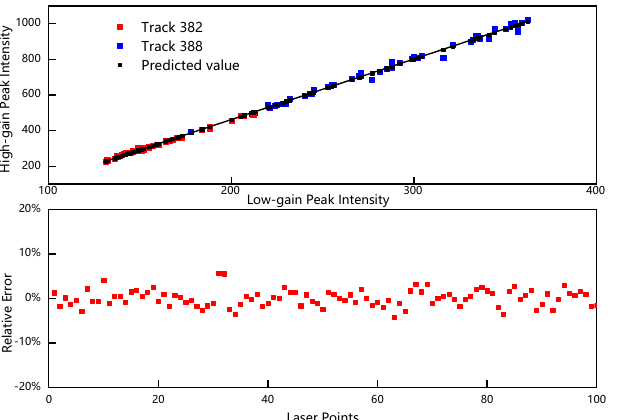
Figure 16. The correlation analysis of the high- and low-gain peak intensity is shown at the top of the graph, where the red points are the measured values for track 382, the blue points are the measured values for track 388, and the black points are the predicted values calculated by the regression model. The relative correction error of the peak intensity of the laser waveform for the unsaturated data set is shown at the bottom of the figure.